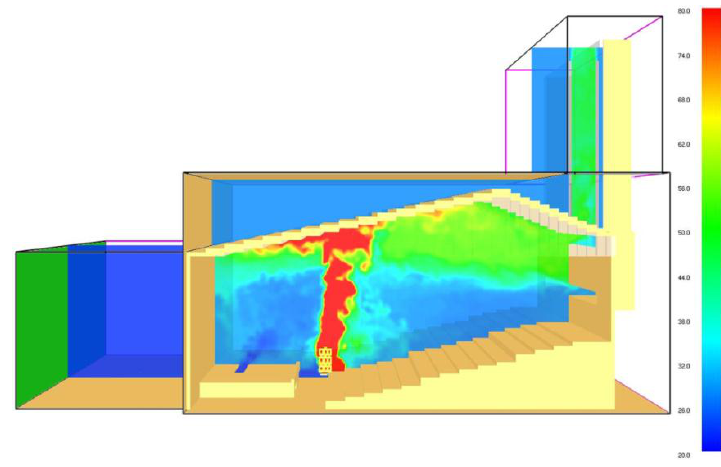
Figure 21. Temperature profile in Case F_BOUO (at 120 s).